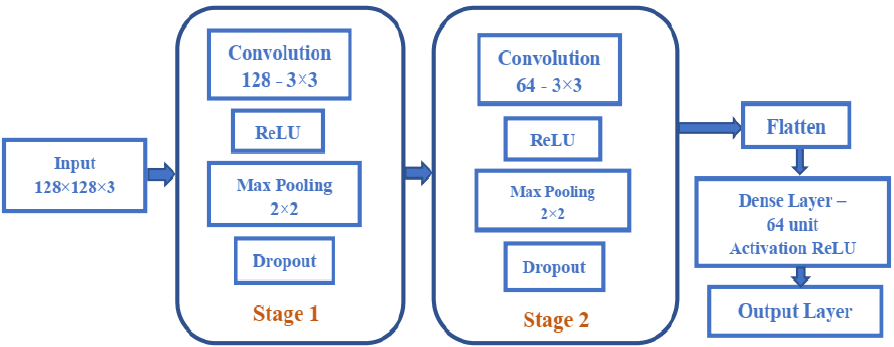
Figure 10. Convolutional neural network architecture.